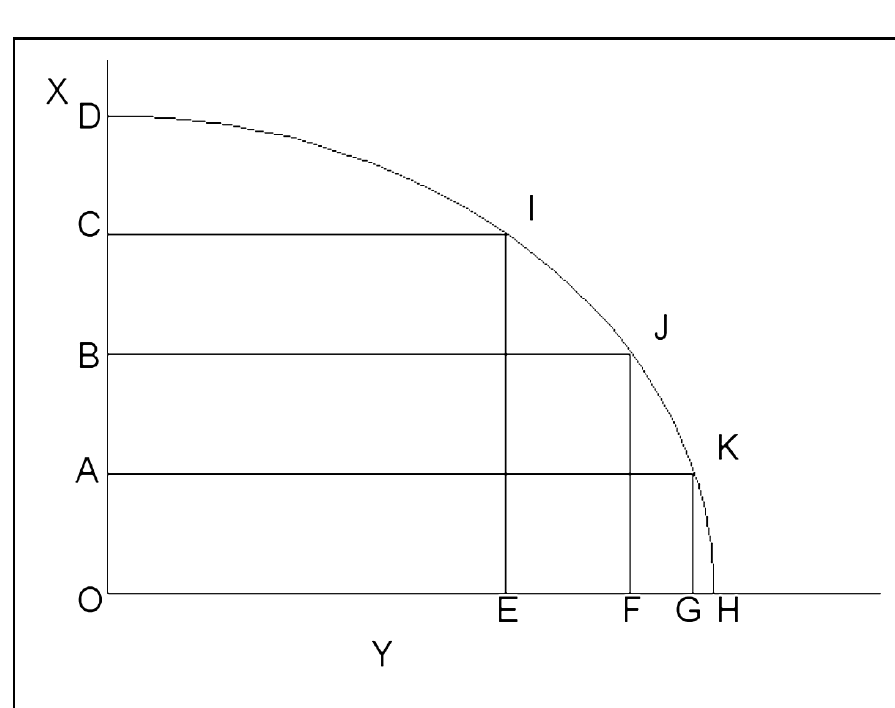
Figure 2.Per capita production